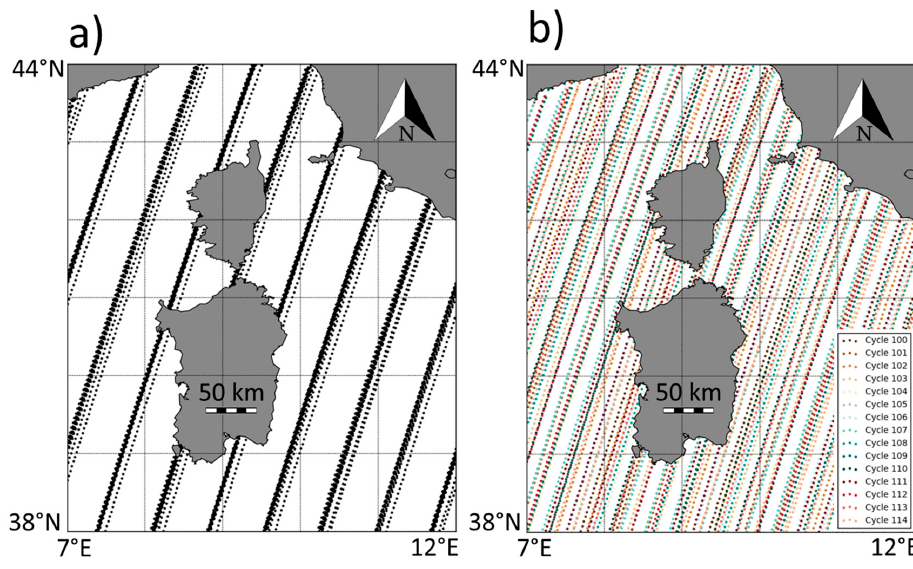
Figure 7. Position of the AltiKa measurements (1 Hz rate of the Geophysical Data Record product) from descending passes over a period of 15 months in the Mediterranean Sea. Panel ( a ) is for the 35-day repeat phase in 2015 and panel ( b ) is for the first 15 months of the drifting phase. In contrast, the SARAL DP coverage is very dense (panel b, Figure 7): after 15 months, the grid resolution is approximately 4 km on average in this region. As discussed in Section 3.4, the geodetic grid is also somewhat random and very irregular: it can locally range from 1 km to 15 km.